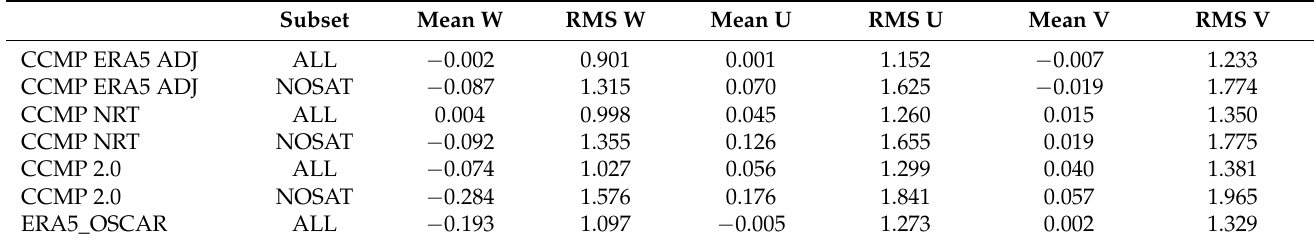
Figure 15. Binned mean differences and RMS differences between wind and ASCAT-B. The left column ( a , c , e ) shows the mean differences for W, U, and V as a function the average wind between the wind variable pairs. The right column ( b , d , f ) shows the RMS differences. In all cases, CCMP ERA5 ADJ shows better agreement with ASCAT-B than the other wind datasets. Table 3. Mean and RMS of Wind differences vs. ASCAT-B over all wind speeds.